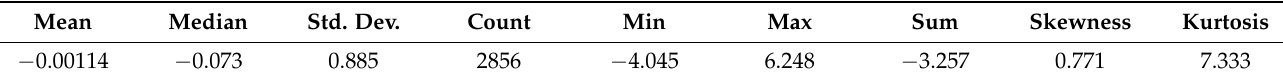
Table 8. Statistics of the GWR standardized residuals.